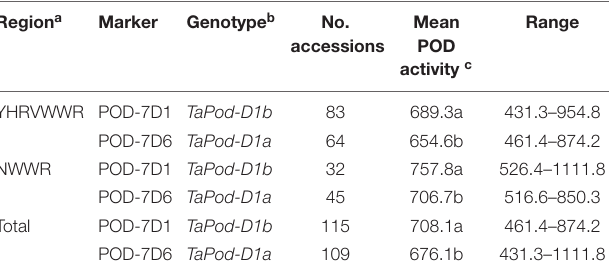
TABLE 3 | Allelic variants at the TaPod-A2 locus in wheat varieties and POD activities with the markers POD-7D1 and POD-7D6. Region a Marker Genotype